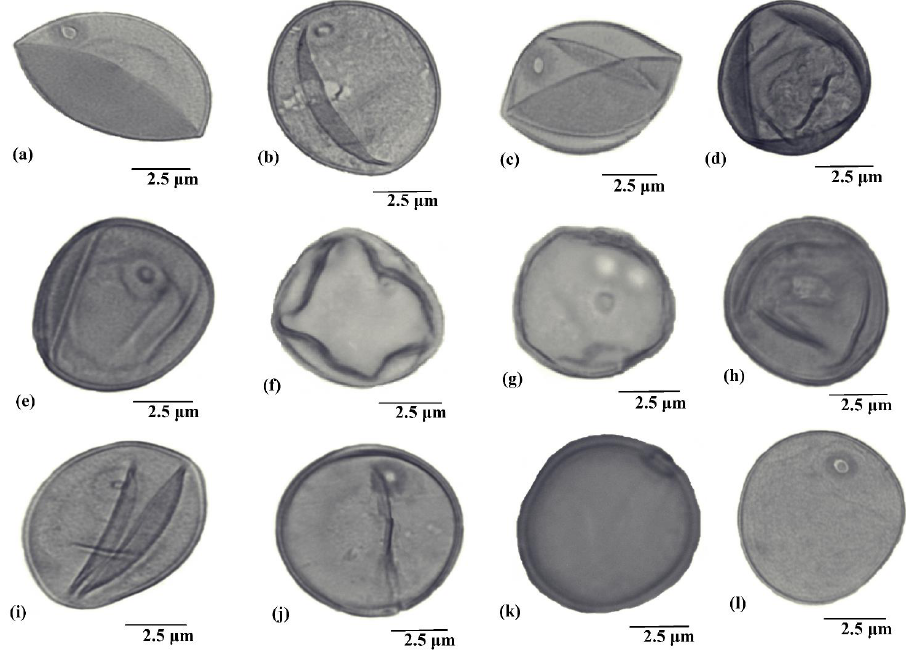
Figure 1. Light microscope pollen micrographs of salt tolerant grasses. ( a ) Calamagrostis pseudophrag- mites , ( b ) Cenchrus biflorus , ( c ) Cenchrus ciliaris , ( d ) Cenchrus pennisetiformis , ( e ) Cymbopogon jwarancusa , Figure 1 . Light microscope pollen micrographs of salt tolerant grasses. (a) Cala- magrostis pseudophragmites , (b) Cenchrus biflorus , (c) Cenchrus ciliaris , (d) Cenchrus penniseti- ( f ) Dactyloctenium aegyptium , ( g ) Echinochloa colona , ( h ) Echinochloa crus-galli , ( i ) Saccharum griffithii , formis , (e) Cymbopogon jwarancusa , (f) Dactyloctenium aegyptium , (g) Echinochloa colona , (h) ( j ) Saccharum ravennae , ( k ) Saccharum spontaneum , ( l ) Urochloa ramosa Echinochloa crus-galli , (i) Saccharum griffithii , (j) Saccharum ravennae , (k) Saccharum sponta- neum , (l) Urochloa ramosa .